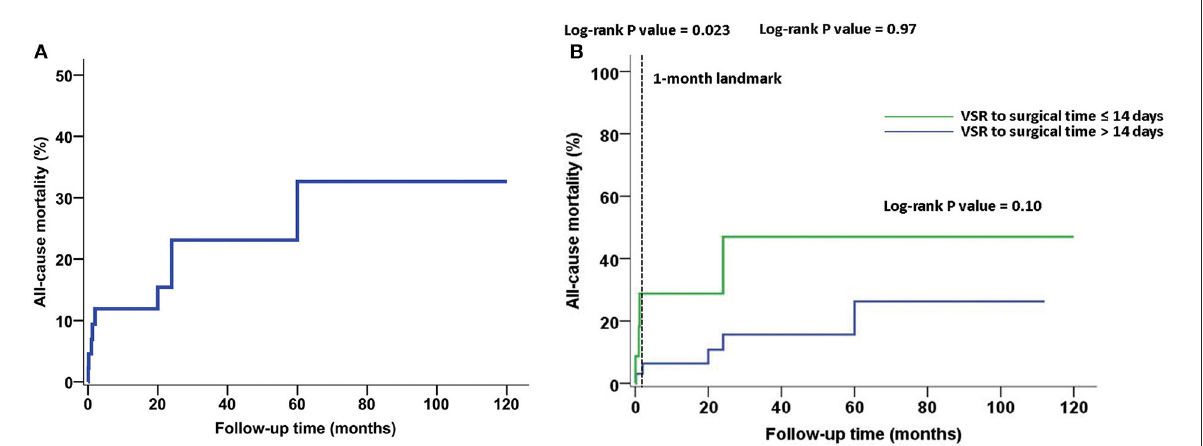
FIGURE1 All-cause mortality during follow-up. (A) The Kaplan–Meier survival curve. (B) The time between ventricular septal rupture (VSR) and repair was not associated with all-cause mortality at ≤ 14 days and > 14 days (33.33 vs. 15.15%; log-rank P = 0.10). However, the 1-month landmark analysis showed that compared to patients with VSR to surgical time > 14 days, those who underwent surgery within 14 days had a higher rate of all-cause mortality (25.00 vs. 3.33%; log-rank P = 0.023).